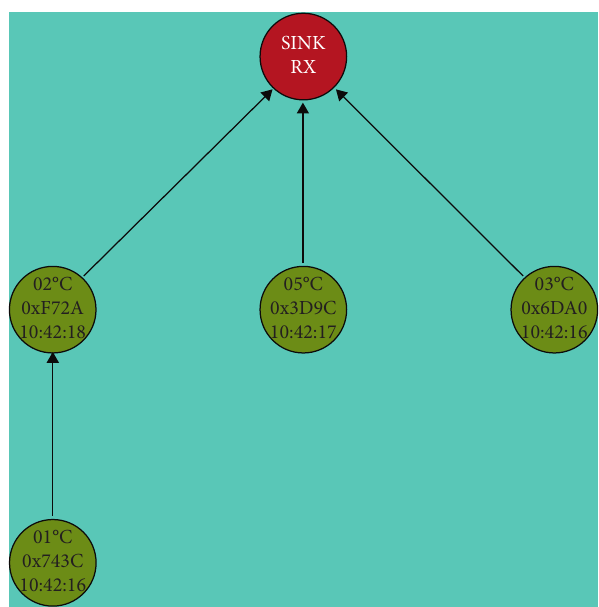
Figure 13: The network topology after a single zigbee node is lost. the right. Tests have shown that the farthest failure distance in this direction is 7.5 meters. On the rear side of the carriage, because the door is open, the critical distance of failure is farther than the right side, and the farthest distance is 26meters.